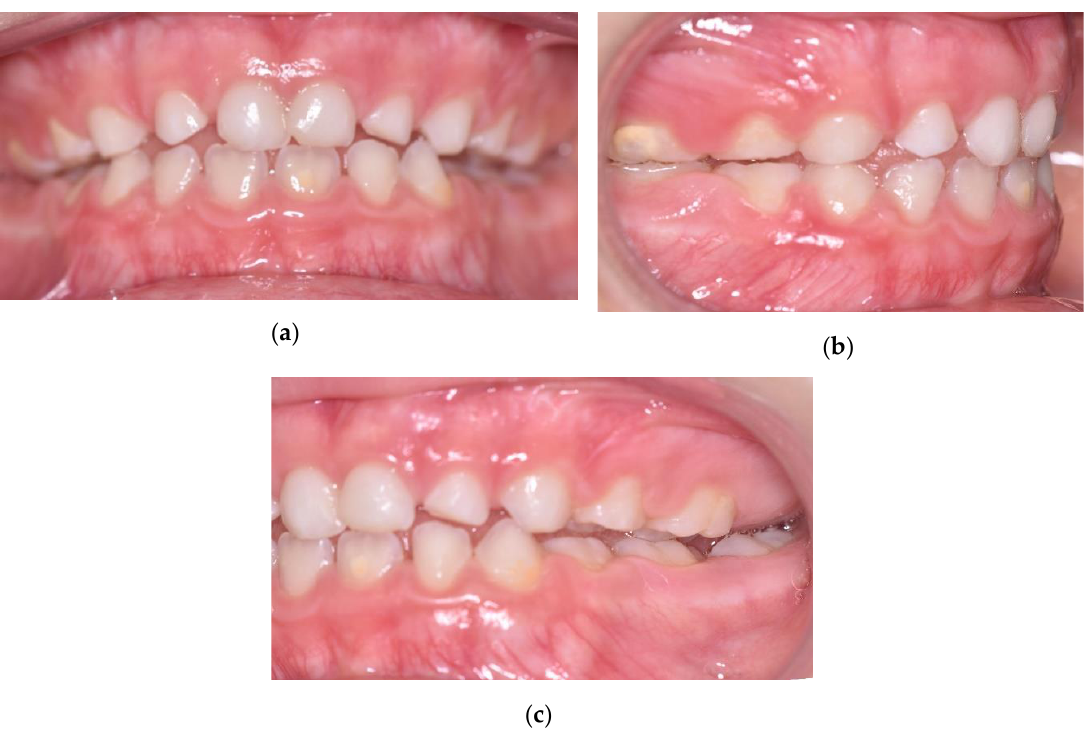
Figure 6. Intraoral post-treatment pictures: ( a ) frontal view; ( b ) lateral view of right side; ( c ) lateral view of left side.